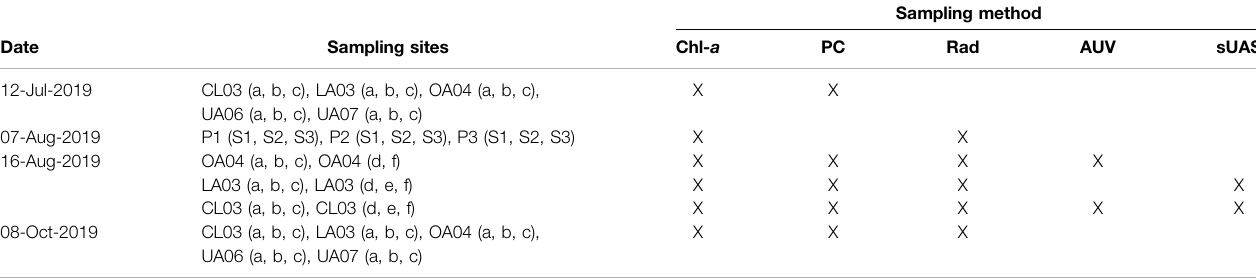
TABLE1| Summaryofdatacollection.SamplingsitesCL03(a,b,c,d,e,f),LA03(a,b,c,d,e,f),P1(S1,S2,S3),P2(S1,S2,S3),andP3(S1,S2,S3)areintheLowerArmof Clear Lake, OA04 (a, b, c, d, f) is in the Oaks Arm, and UA06 (a, b, c) and UA07 (a, b, c) are in the Upper